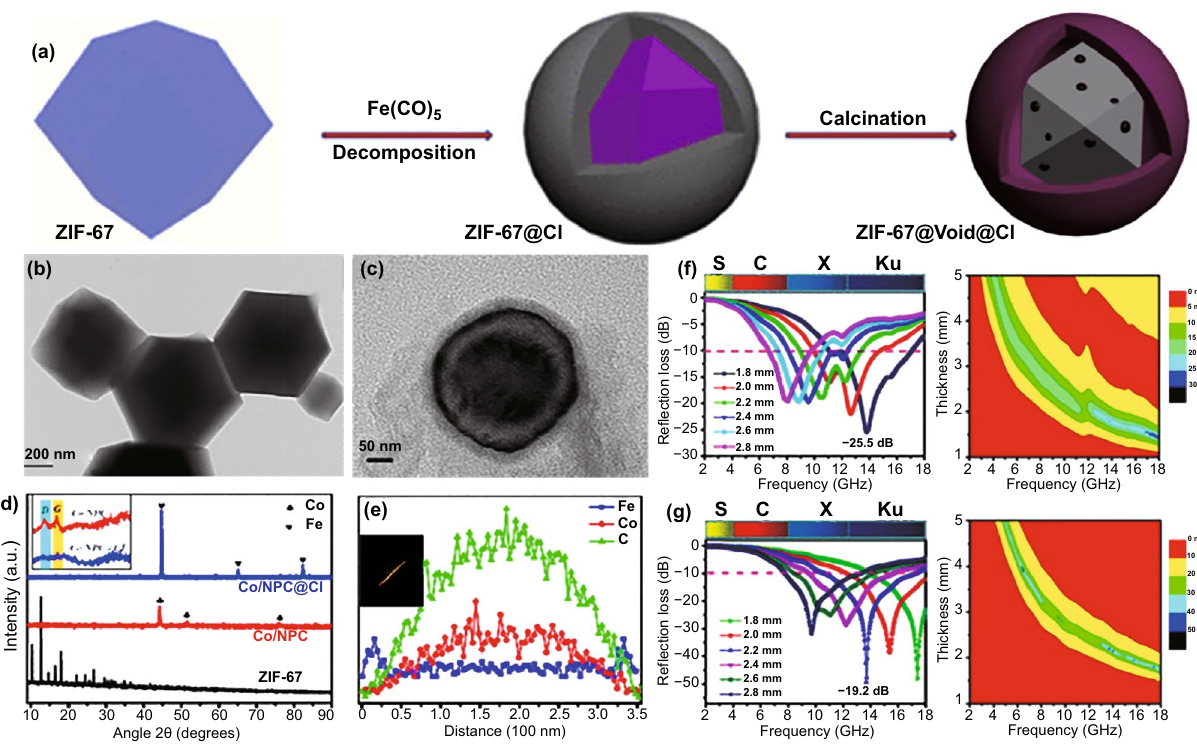
Fig. 3 a Synthetic Scheme for the Preparation of Co/NPC@Void@CI, TEM images of b ZIF-67 and c Co/NPC@Void@CI, and d XRD pat- terns of samples (inset shows the Raman spectra of Co/NPC and Co/NPC@Void@CI. e EDS line scans of Co/NPC@Void@CI, RL maps and RL curves of f Co/NPC and g Co/NPC@Void@CI. Reproduced with permission from Ref. [77]. Copyright © 2017 American Chemical